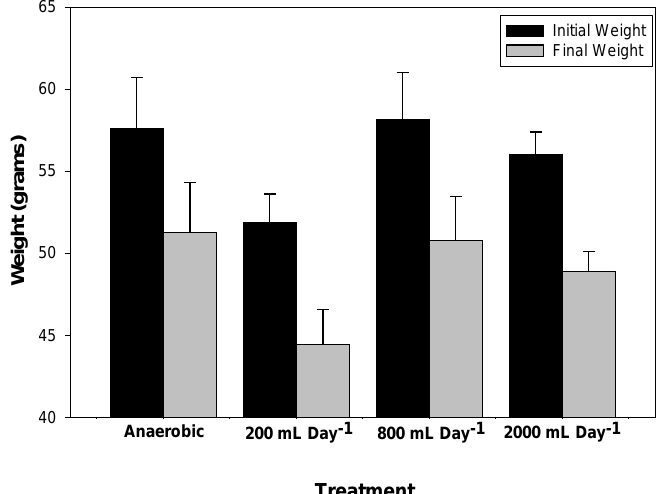
Figure 4. Weights of wood disks at beginning and end of experiment. Data represent the mean of seven determinations ± standard error of the mean.